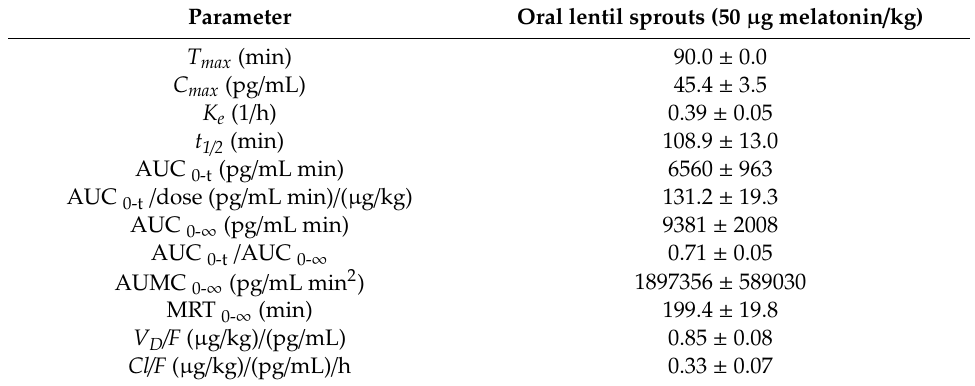
Figure 3. Plasma concentration-time profiles of melatonin ( A ), serotonin ( B ), and antioxidant capacity measured by the FRAP method ( C ) after the administration of lentil sprouts (equivalent to 50 µ g / kg melatonin). Each point represents the mean ± SD ( n = 8). Table 4. Pharmacokinetic parameters of melatonin in rats after oral administration of lentil